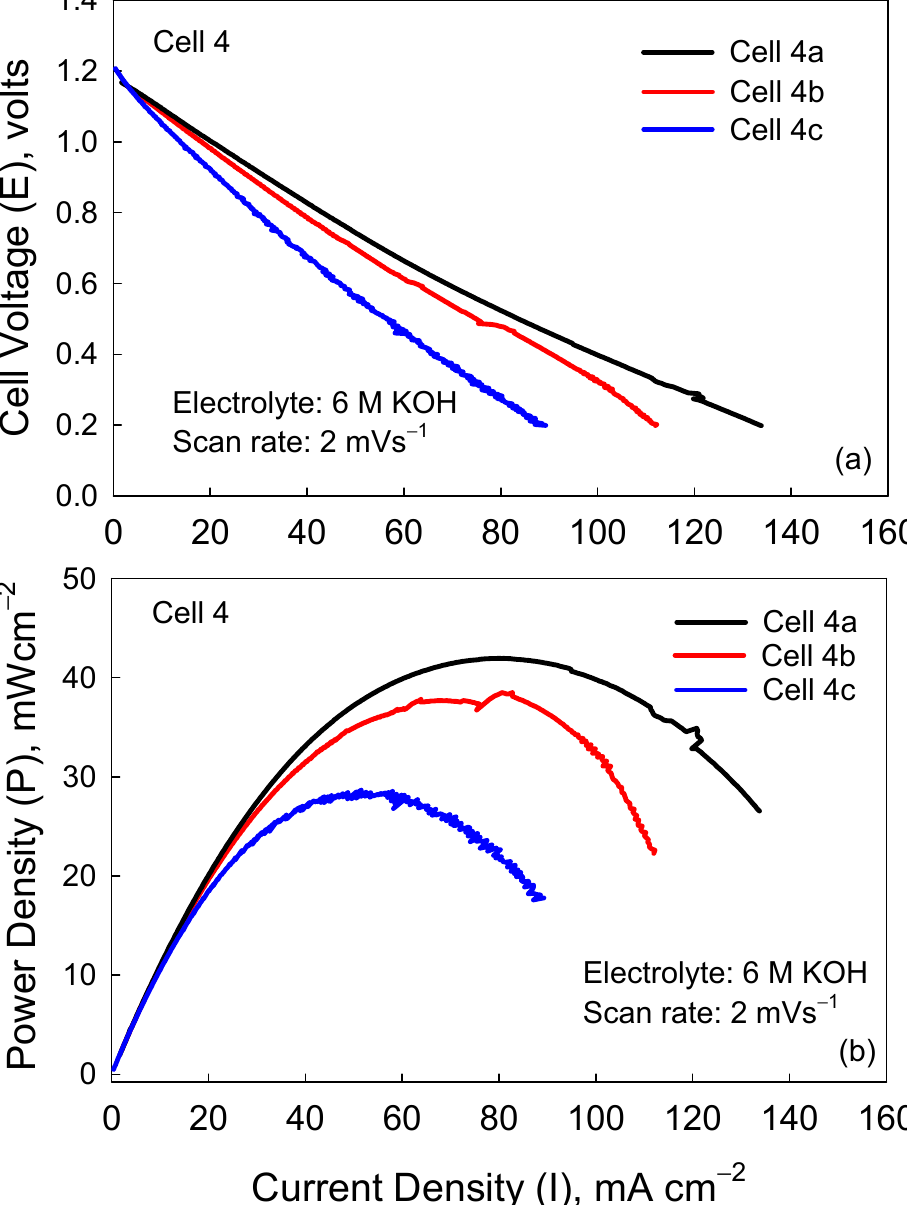
Figure 9. The E-I and P-I curves of Cells 4a–c with 25BC as the ORR electrode, ( a ) E-I curves; ( b ) P-I curves. Three spacers with thicknesses of 0.5, 1.0, and 1.5 cm were used in Cell 4a, 4b, and 4c, respectively.